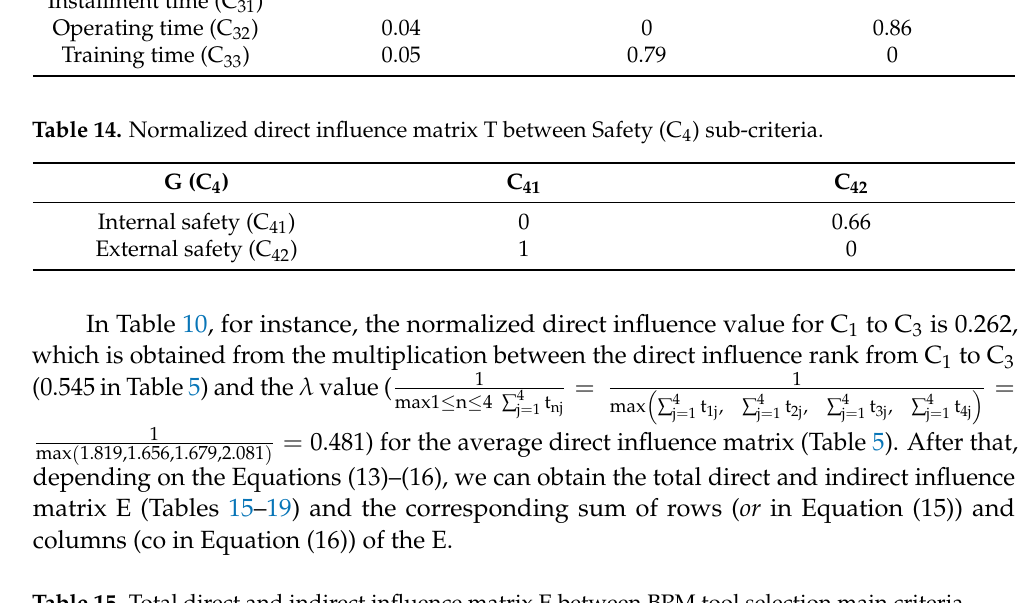
Table 15. Total direct and indirect influence matrix E between BPM tool selection main criteria.